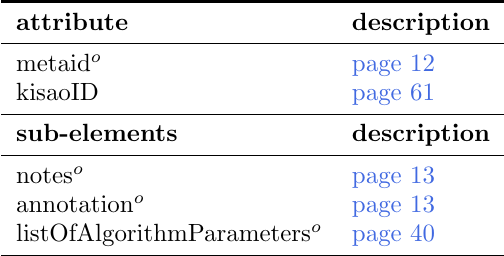
Table 2.17: Attributes and nested elements for algorithm. o denotes optional elements and